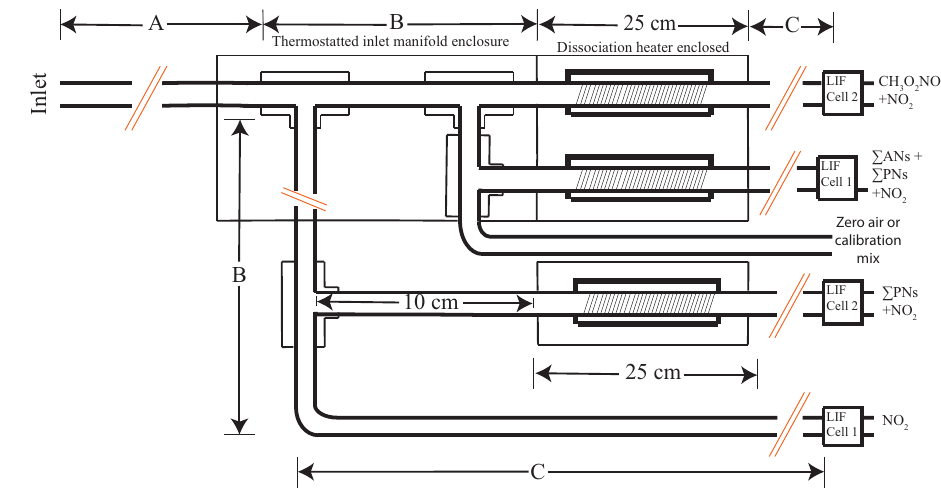
Figure 3. Schematic of the TD-LIF inlet sampling manifold. Arrows and letters refer to lengths referenced in Table 1. The species measured in each channel is shown at the right, where (cid:54) PNs ≡ PAN + PPN + CH 3 O 2 NO 2 + HO 2 NO 2 + ... and (cid:54) ANs ≡ the sum of gas and aerosol alkyl and multifunctional nitrates.